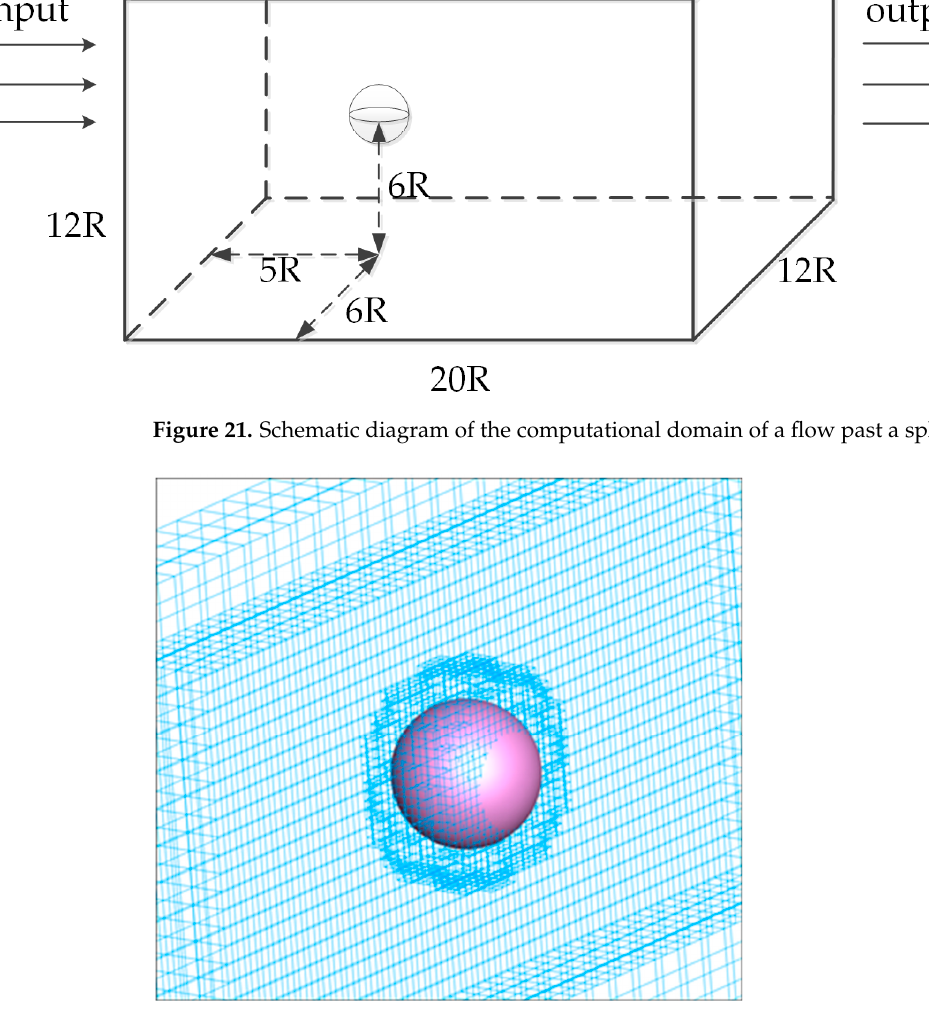
Figure 22. Schematic diagram of three-level grid of flow past a sphere in 3D case.